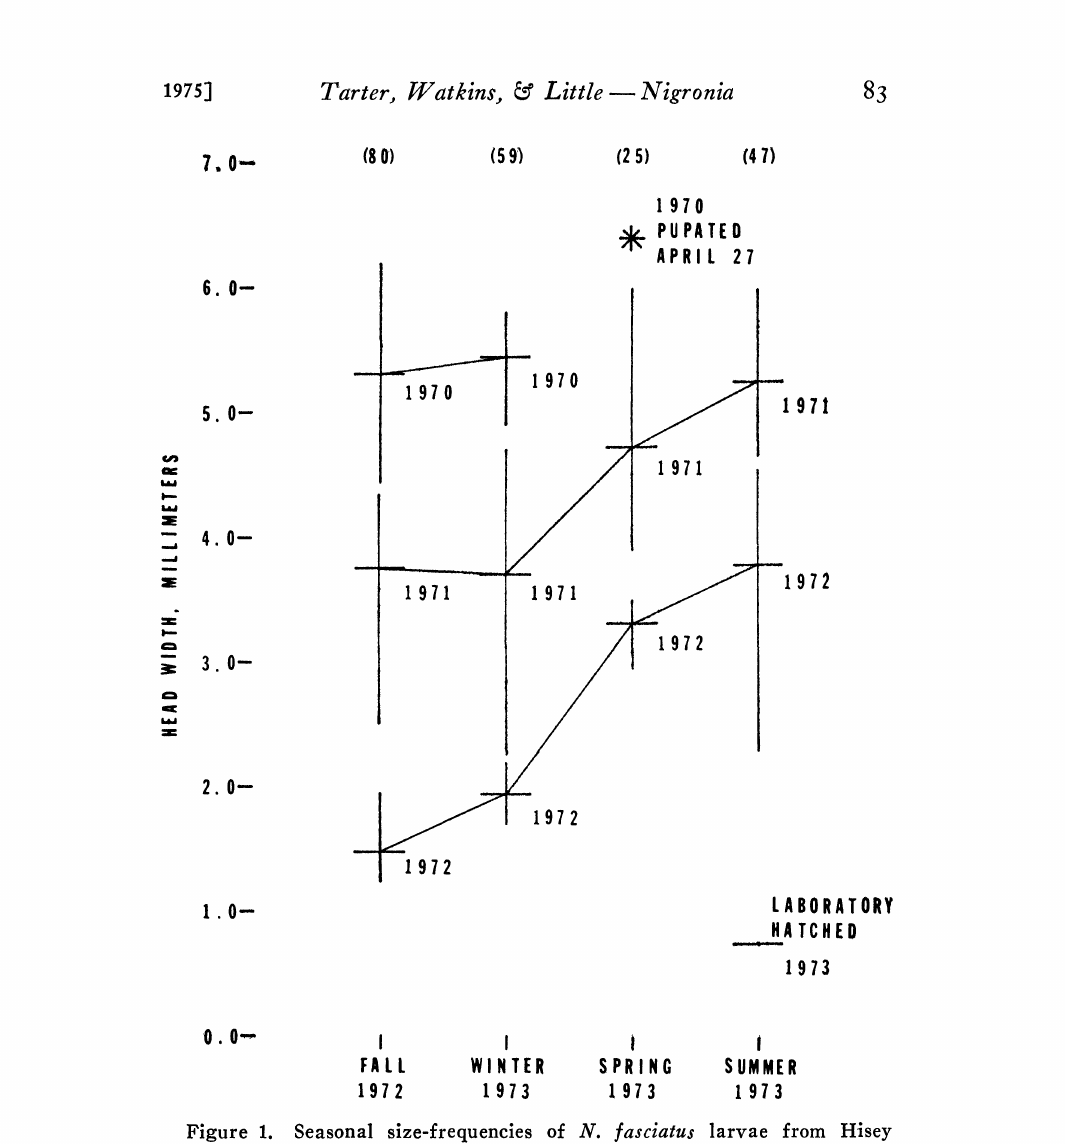
Figure 1. Seasonal size-frequencies of N. fasciatus larvae from Hisey Fork, Cabell Co., W. Va. Number of larvae is given in parentheses, and size classes are marked with year o.f